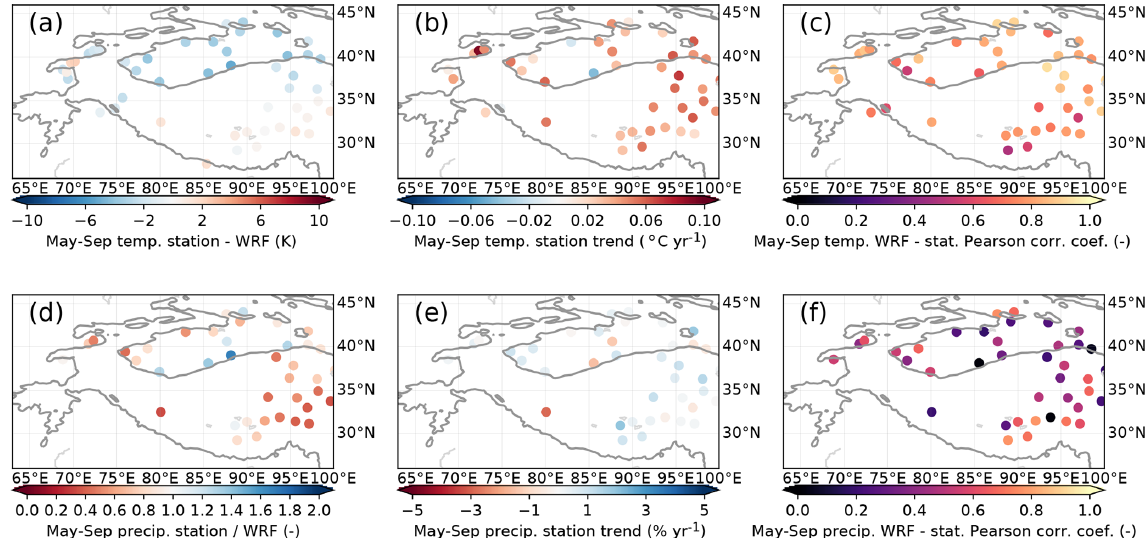
Figure 2. Comparisons between 1980 and 2010 time series of station data and nearest WRF grid point for May–September temperatures (a–c) and May–September precipitation (d–f) . Columns show temperature bias (a) and precipitation multiplication factor (d) , station trends (b, e) , and Pearson correlation coefficients. The 2000m contour is indicated by a solid